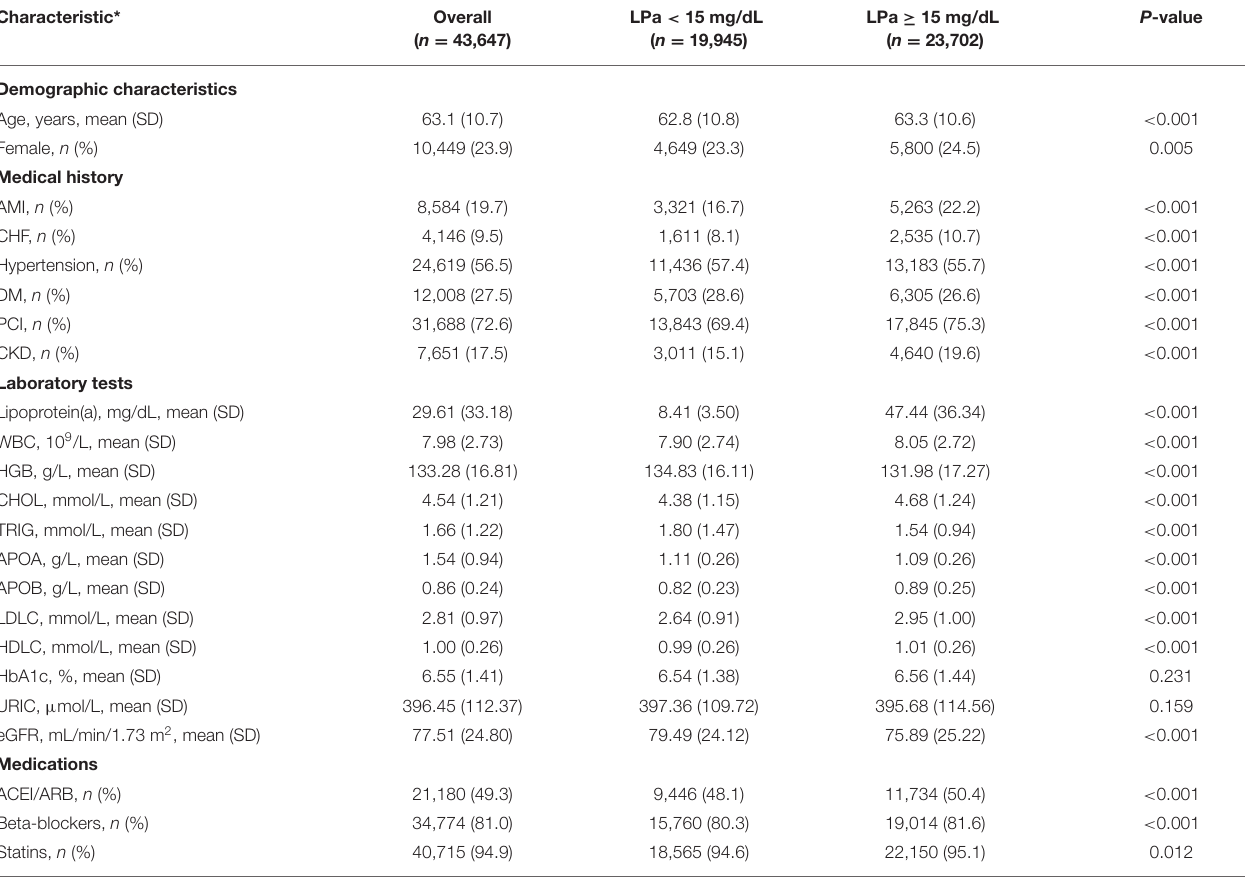
TABLE 1 | Baseline characteristics of the patients.